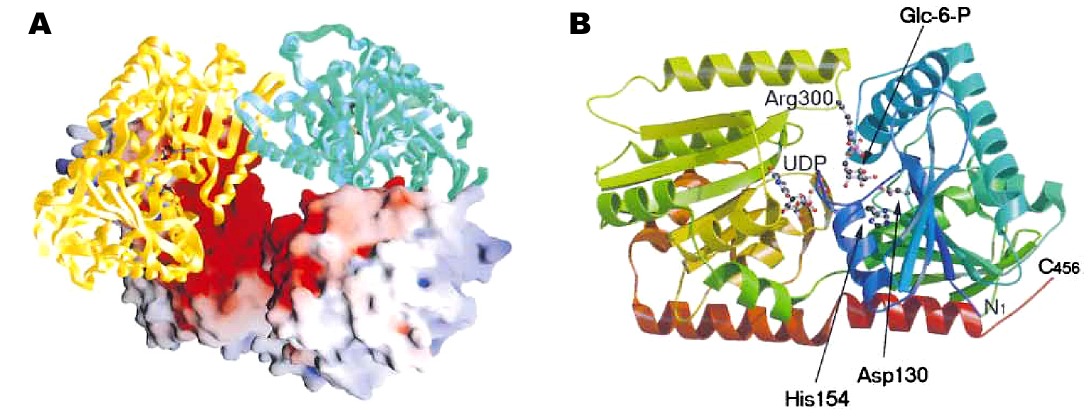
Figure 5. Crystal structure of trehalose-6-phosphate synthase (OtsA) provided by Gibson et al . [185]. (A) Tetramer of the enzyme. The electrostatic surface representation (positive, blue; negative, red) and the protein cartoon figure are mixed. (B) Ribbon representation of the structure of OtsA. The two ligands, glucose-6-phosphate and UDP, are shown in ball- and-stick model. Figure courtesy of Professor G. J. Davies and Cell Press. A